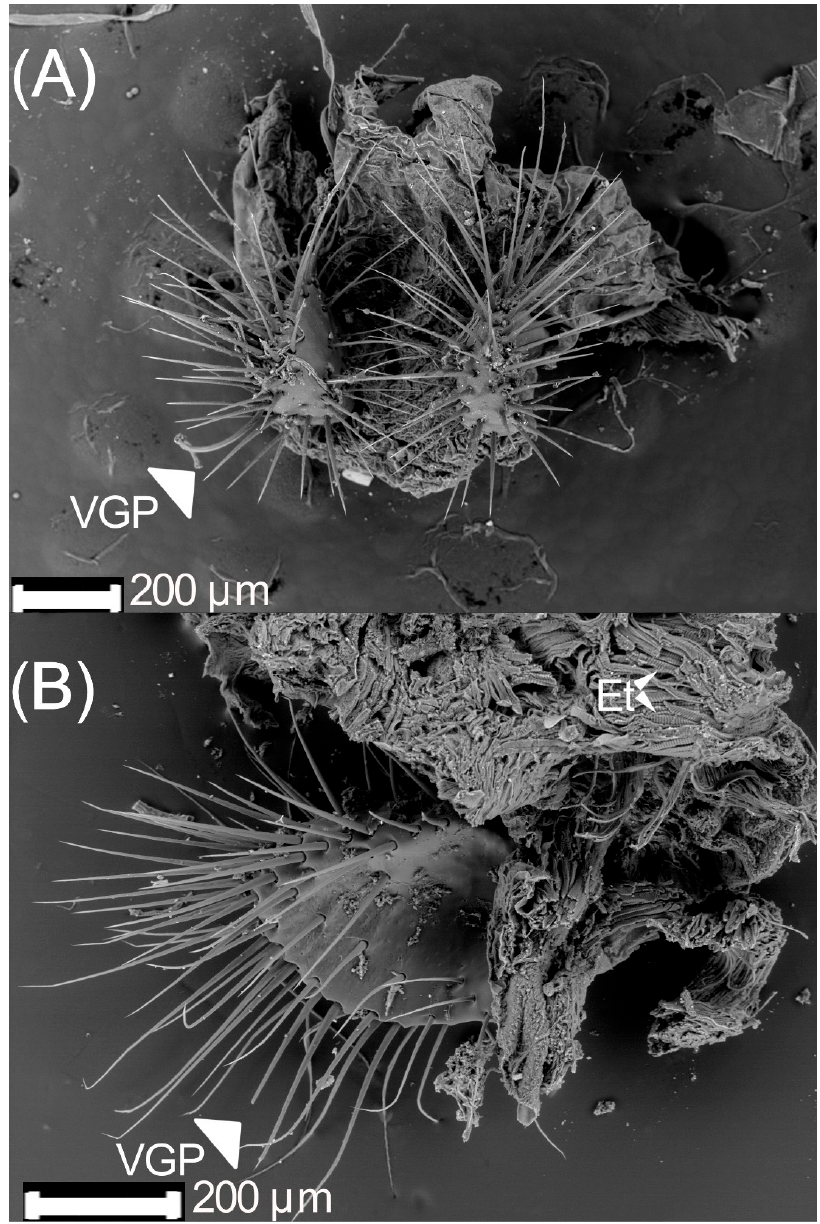
Figure 7. Ventral genital plates of 18 d old Cyclocephala barrerai virgin female: ( A ) ventral genital plates (front view), ( B ) ventral genital plates (lateral view). VGP = ventral genital plates.